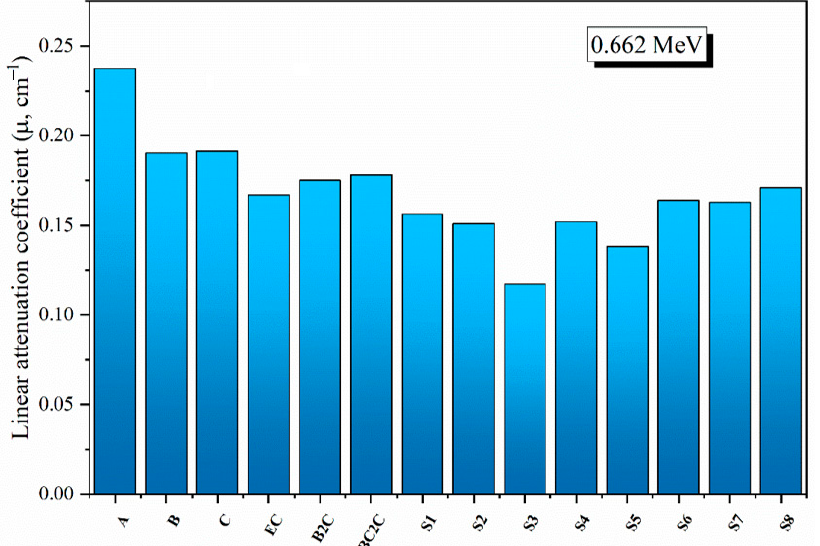
Figure 6. Comparison of the µ values for the fabricated concretes and previously published con- at E γ = 0.662 cretes, at E γ = 0.662 MeV.